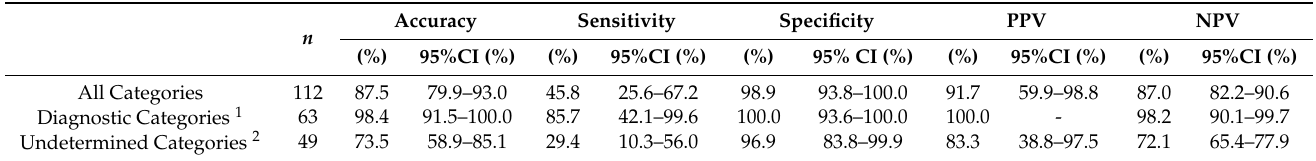
Table 2. MSRSGC: Diagnostic Accuracy